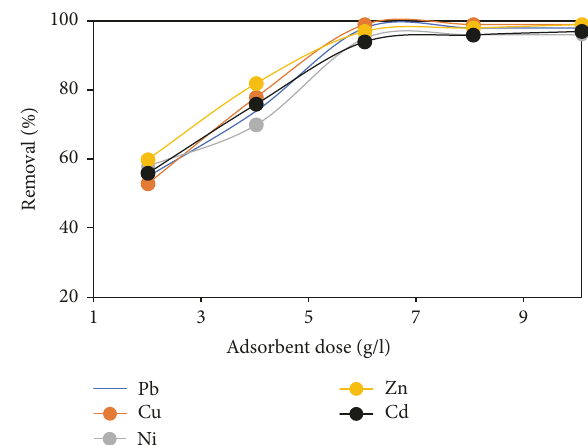
Figure 9: Effect of contact time on percentage removal of heavy metal ions by FGCX (conditions: 7 g/l FGCX; pH: Pb = 5, Cu = 5, Ni = 7, Zn = 6, and Cd = 6; contact time: 60 min; initial concentration: 0.8 mmol/L; agitation speed: 120rpm).